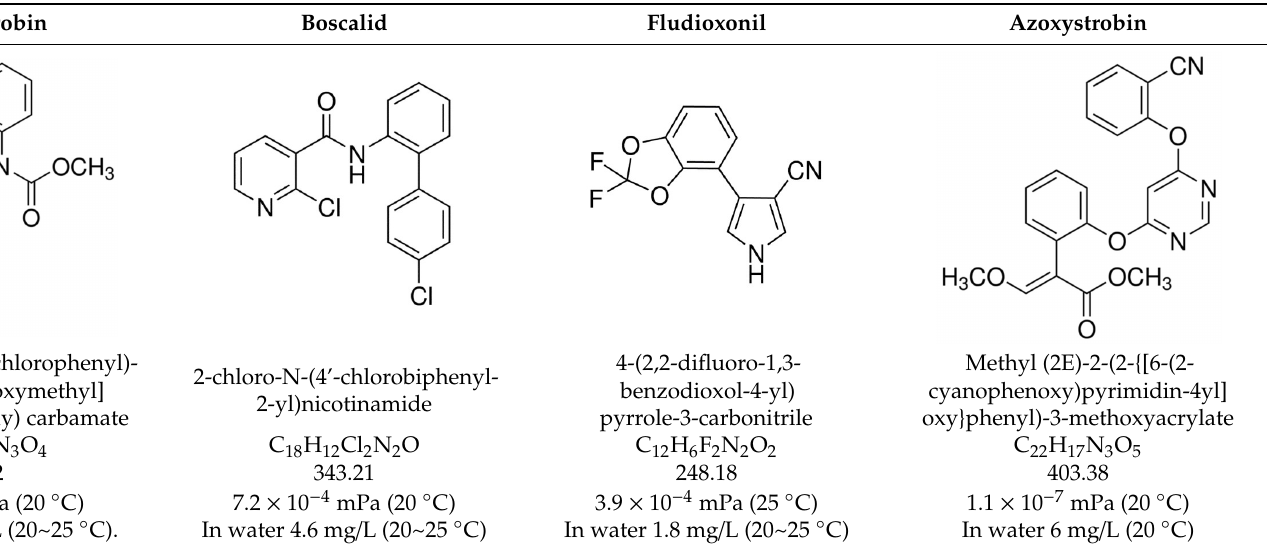
Table 1. Chemical structure and physicochemical properties of pesticides.